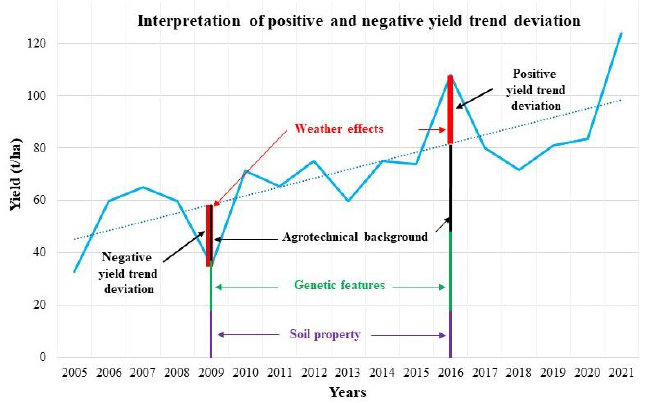
Figure 2. Illustration for the linear trend caused by soil properties, genetic features, agrotechnical background, and deviations from this trend. (Original Figure by Laszlo Lakatos).